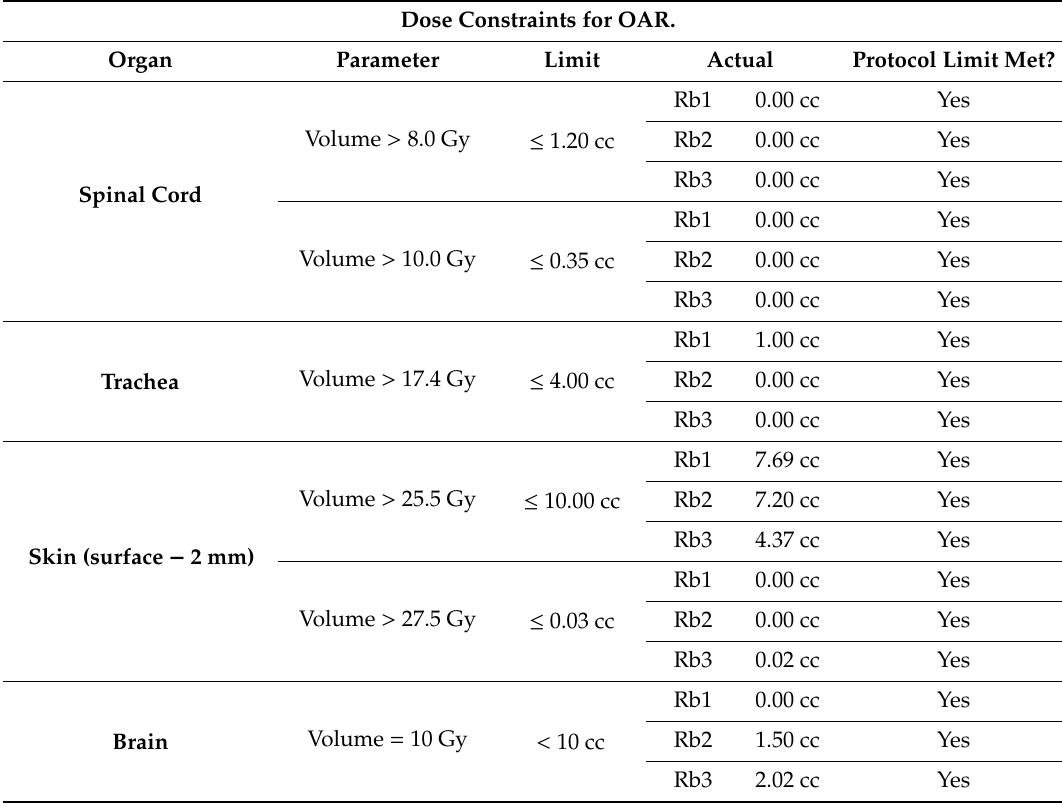
Table 2. Dose Limits on Critical Structures (from NRG-BR002 and RTOG). Dose Constraints for OAR.